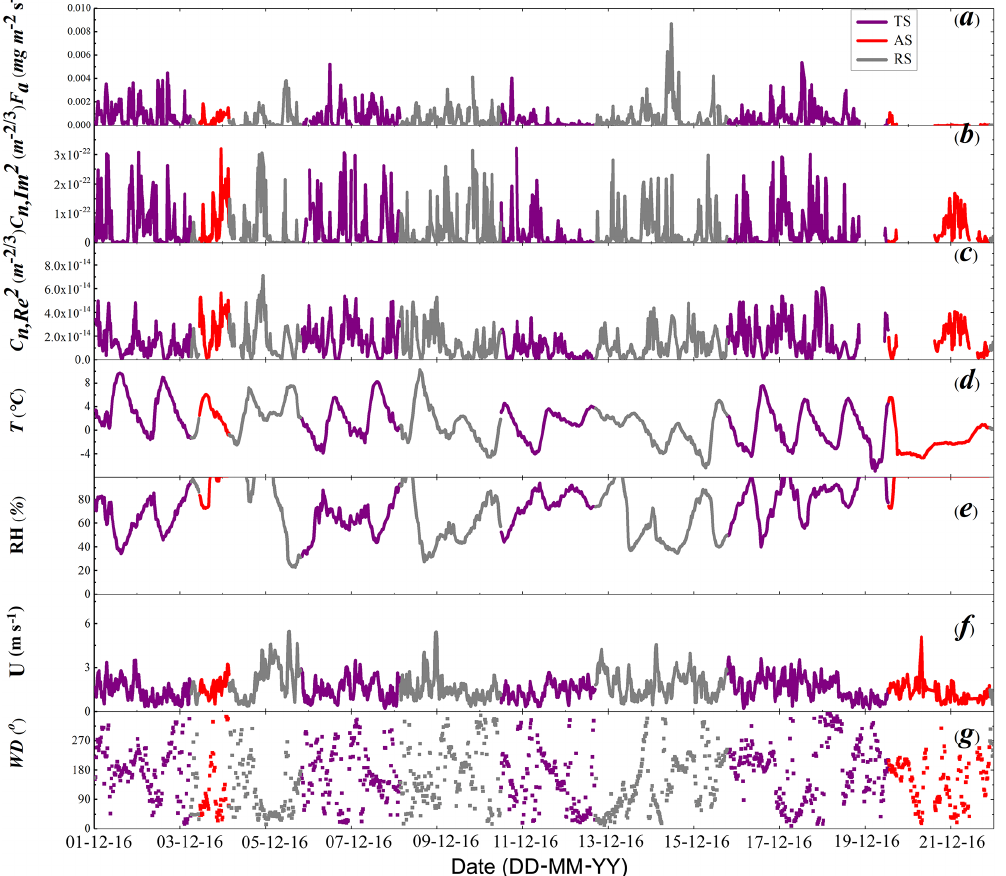
Figure 5. Temporal variations in (a) aerosol flux, (b) imaginary part of the AERISP, (c) real part of the AERISP (d) air temperature, (e) RH, (f) wind speed, and (g) wind direction in the Baoding area during a heavy pollution period, i.e. 1 to 22 December